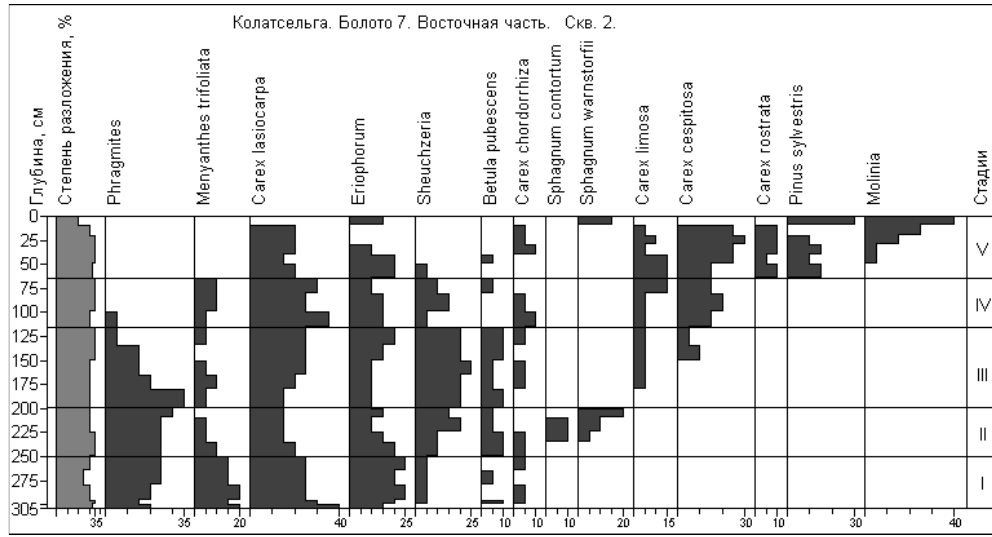
Figure 11. Raimo Heikkilä and Oleg Kuznetsov coring Mire 14 close to Kolatselkä village in 2008 (photo: Tapio Lindholm).